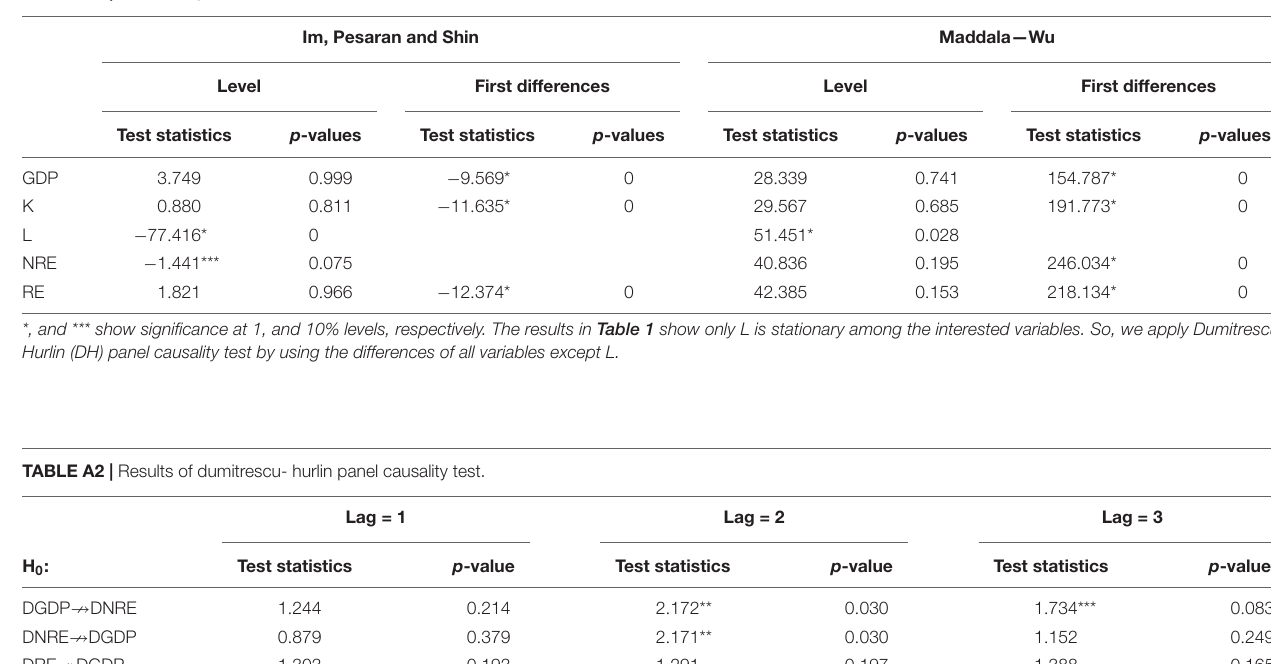
TABLE A1 | Results of panel unit root tests.